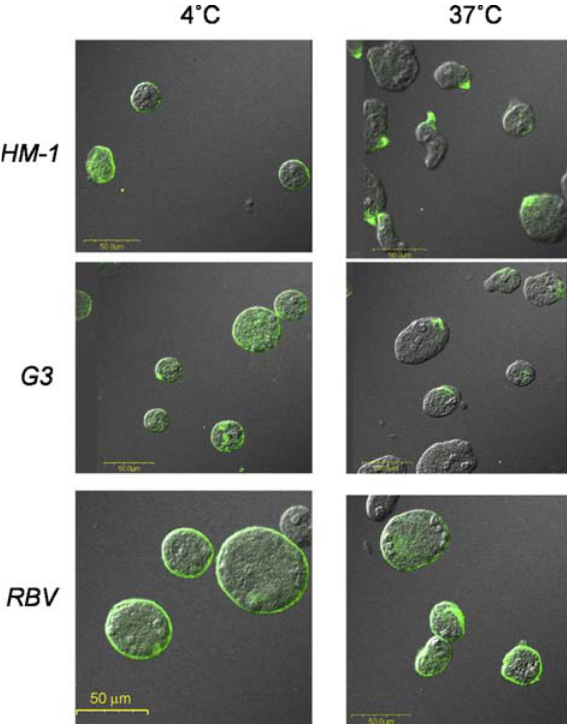
Figure 5. Silencing of Cysteine Proteinase 5 (EhCP5) (A) Diagram of the pAP-CP5 construct. (B) Northern blot analysis. Lanes: 1, RNA from untransfected HM1:IMSS; 2, RNA from untransfected G3; 3, RNA from G3 transfected with pAP-CP5 (probes used are as indicated). DOI: